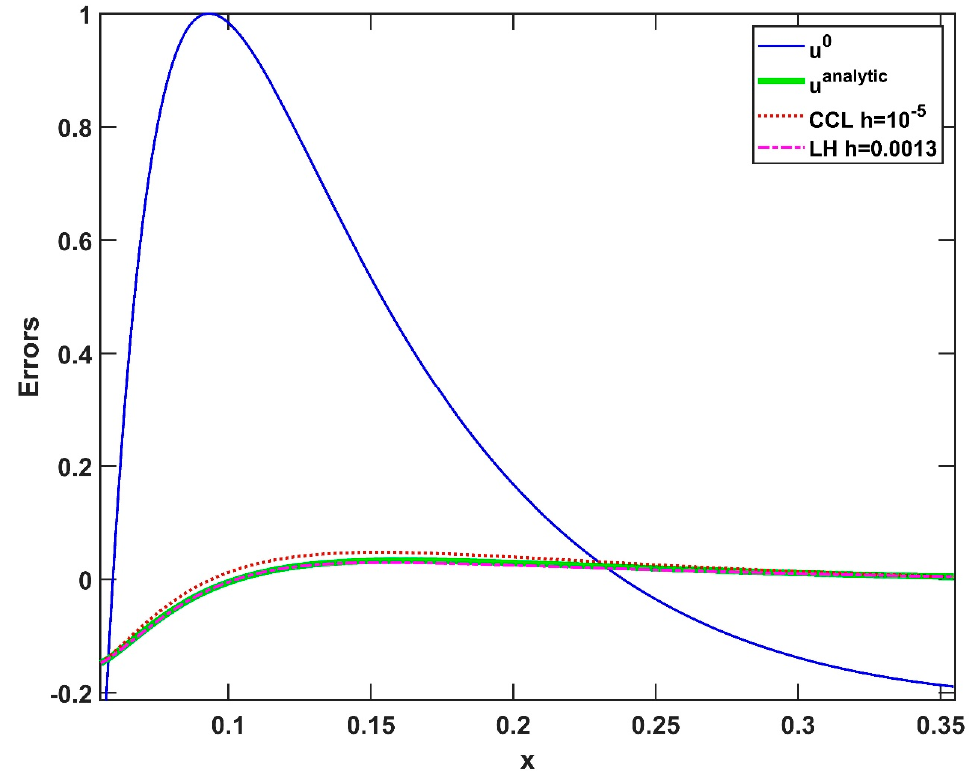
Figure 6. The variable u as a function of x in the case of the initial function u 0 , the analytical solution at the final time, the CCL algorithm for h = 10 − 5 , and the LH algorithm for h = 0.0013 in the case of small value of m (Experiment 1). It is worth emphasizing again that for these time-step sizes, explicit Runge–Kutta algorithms are unstable.